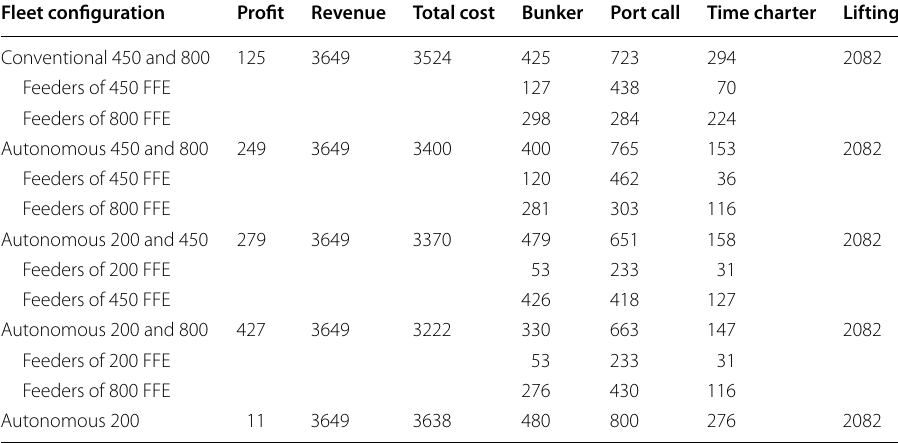
Table 7 Results of the static LSNDP for the low demand scenario (in thousand